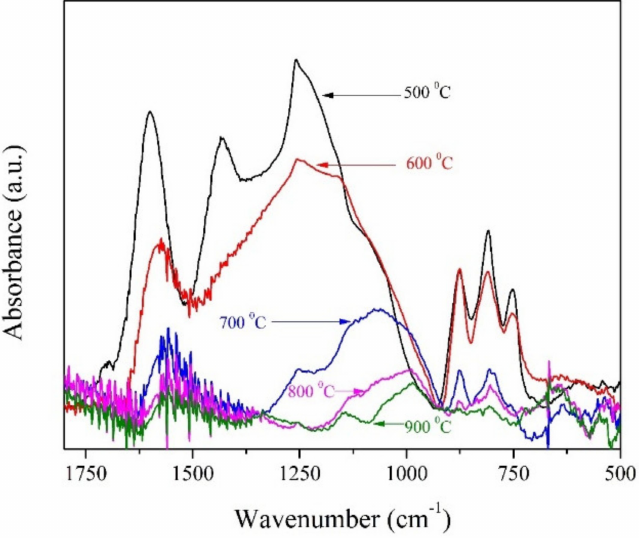
Figure 2. FTIR spectra of CXs obtained at different carbonisation